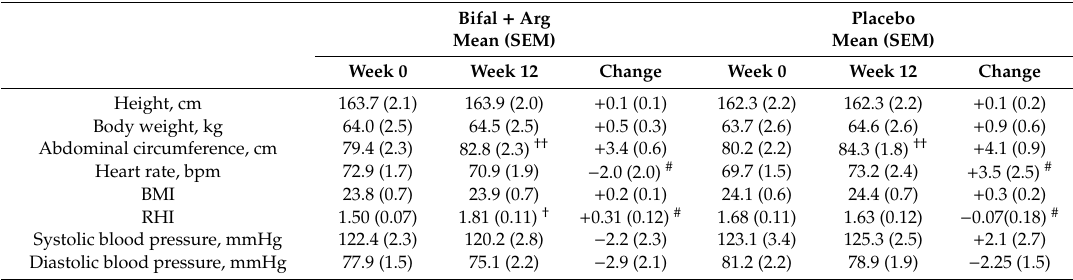
Table 1. Characteristics of subjects’ background and e ff ects of yogurt containing B. animalis subsp. lactis and arginine on physical parameters, RHI, and blood pressure.